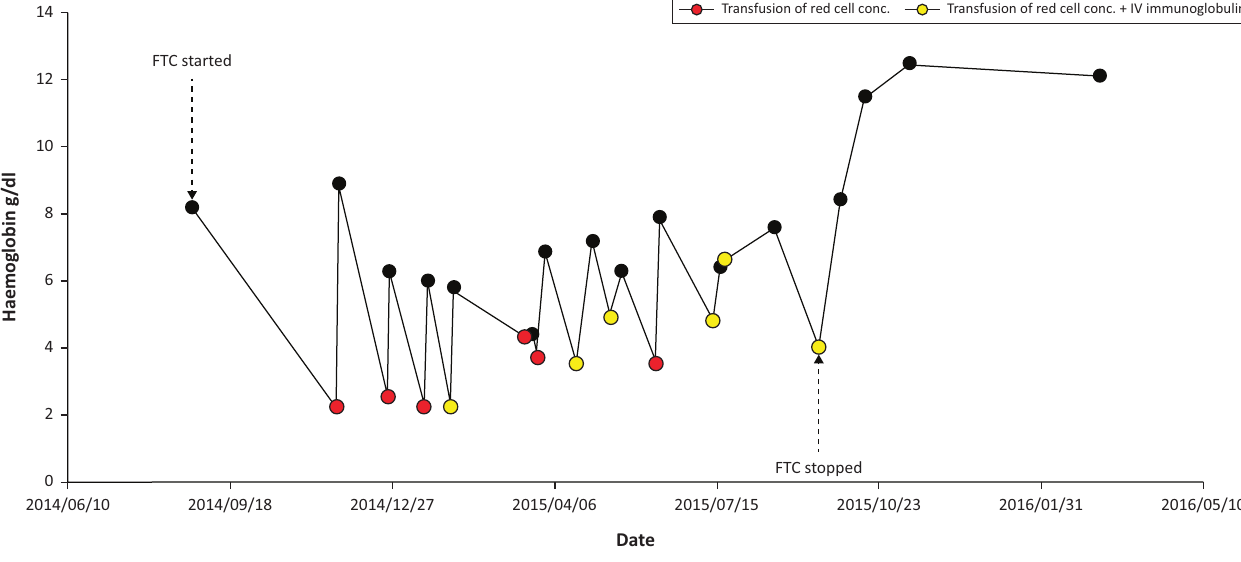
FIGURE 1: Changes in haemoglobin over